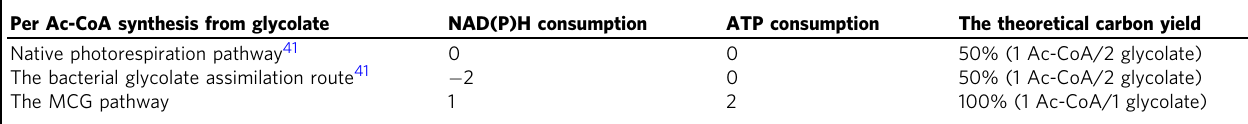
Table 2 Comparison of ATP/NADH consumption and carbon yield among different pathways in assimilation of glycolate to produce acetyl-CoA Per Ac-CoA synthesis from glycolate The theoretical carbon yield Native photorespiration pathway 41